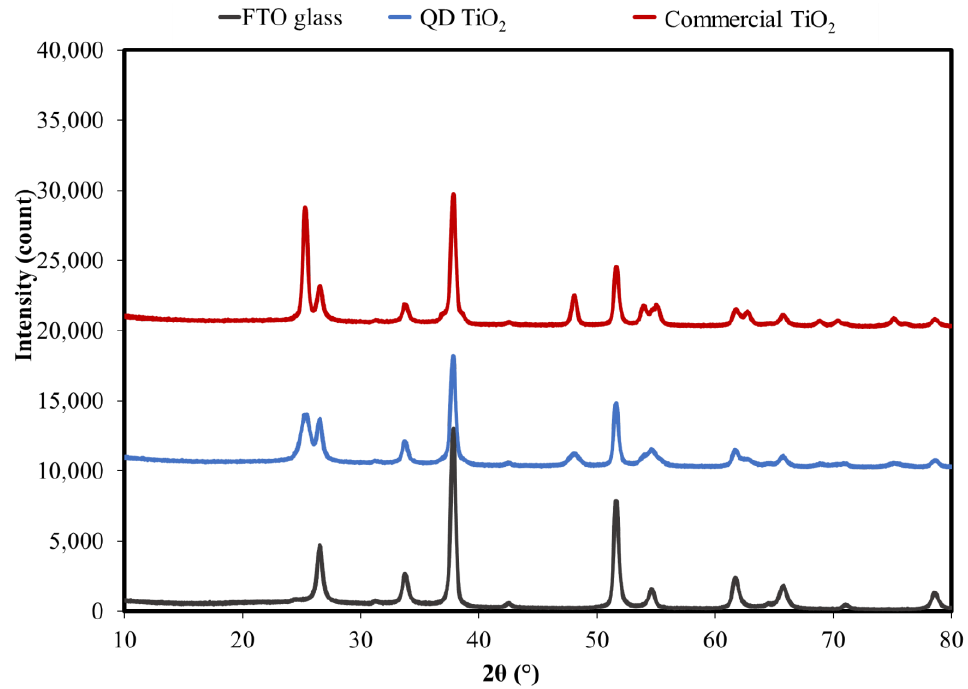
Figure 4. The XRD of the QD TiO 2 and commercial TiO 2 samples printed on FTO substrates.